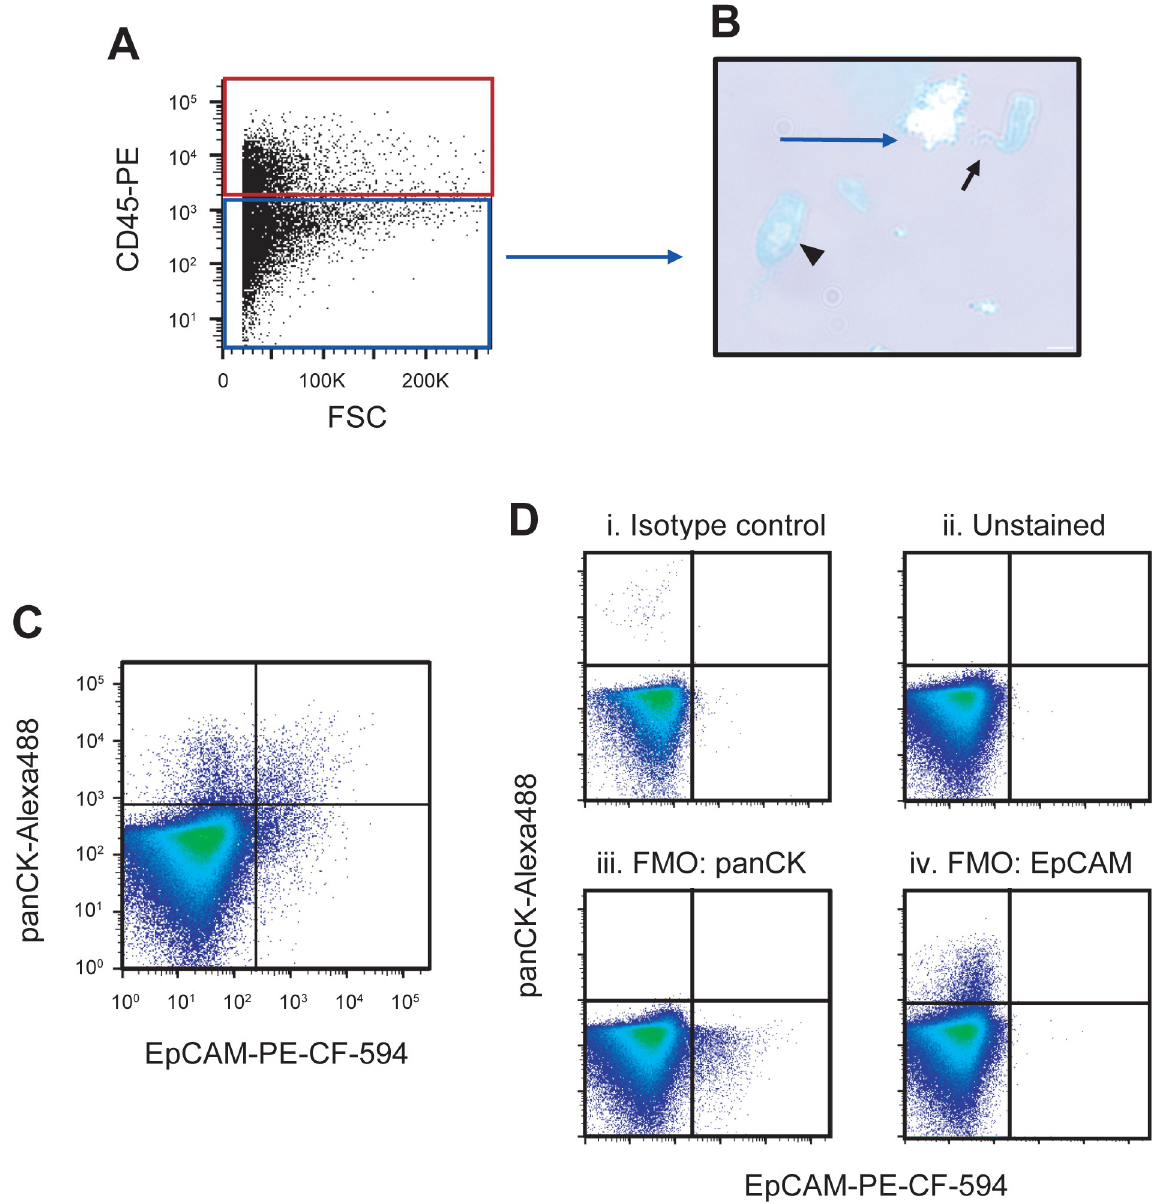
Fig 5. Sputum-derived non-leukocytes identifying epithelial cell populations. All profiles present cells selected through a size exclusion gate and a live cell gate as shown in Fig 1, as well as a doublet discrimination gate (not shown). A ) The same cell suspension used to sort CD45 + cells as presented in Fig 3, was used to sort the CD45 - fraction (blue gate). B ) Wright-Giemsa-stained CD45 - cells. The arrow indicates a ciliated epithelial cell and arrowhead indicates a goblet cell. All images were confirmed by a pathologist. Scale bars indicate 20 μ m. C ) Live, single CD45 - sputum cells, from a different sample, stained with the epithelial antibody panel. D ) Fluorescence minus one (FMO) controls for the profile presented in C . FMO controls include viability dye, CD45, and TCPP. Di ) Sputum-derived epithelial profile of FVS510 - CD45 - cells stained with the isotype controls for the antibodies used in C . Dii ) Unstained sputum cells. Diii ) FMO control FVS510 - CD45 - cells stained with EpCAM but without the panCK antibody. Div ) FMO control FVS510 - CD45 - cells stained with panCK but without the EpCAM antibody.